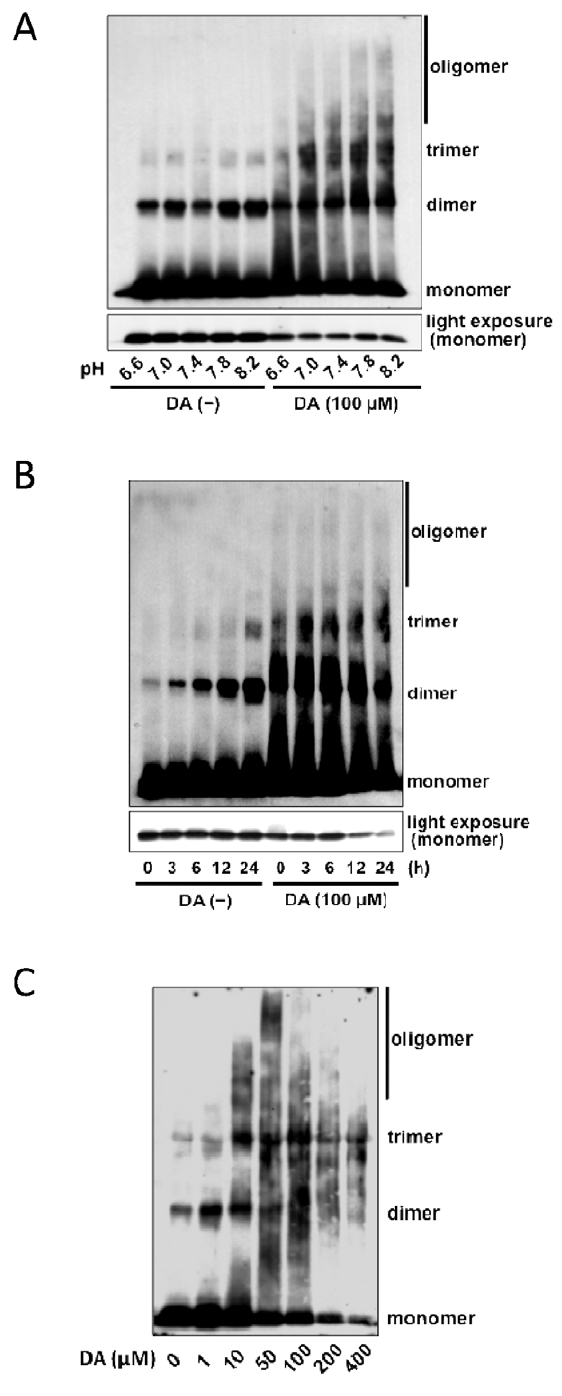
Figure 1. DA enhances oligomerization of a -syn in vitro . (A) Western blots showing that the oligomerization of biotinylated a -syn is enhanced by co-incubation with DA, especially under alkaline conditions (24 h). Biotinylated a -syn (20 m M) was incubated with (100 m M) and without ( 2 ) DA under several pH conditions (6.6–8.2). a -syn incubated with DA resulted in greater oligomerization than the a - syn in the absence of DA. The bottom panel shows the monomer a -syn visualized by light exposure when the film was developed. (B) Time course of oligomerization of a -syn. Although a -syn formed some oligomers gradually in the absence of DA ( 2 ), a -syn oligomerized much more rapidly in the presence of DA (100 m M, pH 8.2). The bottom panel shows the monomer a -syn visualized by light exposure when the